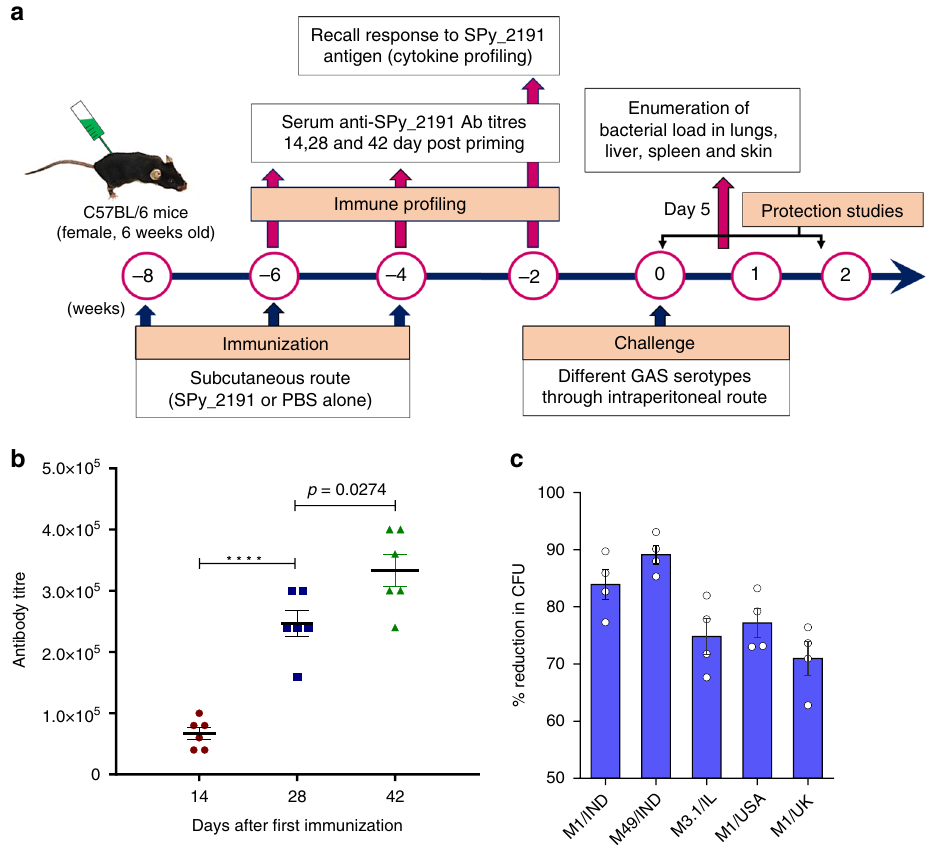
Fig. 2 SPy_2191 induces humoral immune response. a Immunization schedule in C57BL/6 mice. b SPy_2191 speci fi c total IgG endpoint titres in sera samples ( n = 6 mice) collected 2 weeks after priming (day 14) and booster immunizations (day 28 and 42), was measured by Indirect ELISA. One-way ANOVA followed by Tukey ’ s multiple-comparison test was employed for calculating the signi fi cant difference. Data are presented as mean values± SEM c Opsonophagocytic activity of SPy_2191 speci fi c antibodies containing sera ( n = 4), was evaluated for bactericidal assay, against various GAS serotypes, viz. M1/IND, M49/IND, M3.1/IL, M1/USA, and M1/UK. Percent reduction of CFU by SPy_2191-immunized sera was estimated in comparison to PBS- immunized mice sera, used as control. Data are presented as mean values ± SEM. **** P <